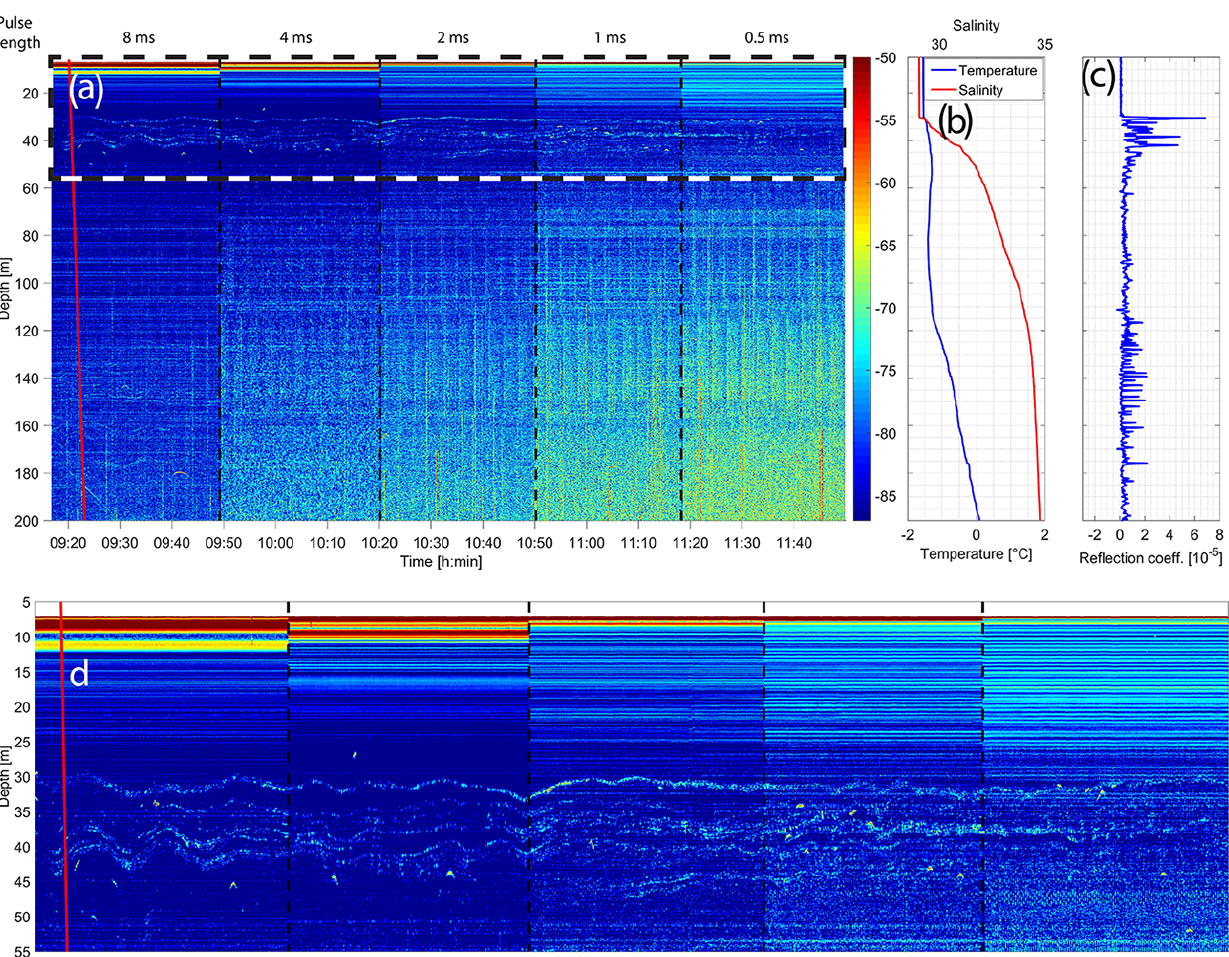
Figure 4. Comparison of EK80 data with different pulse lengths. Data were acquired on 26 August 2016 at 140.6 ◦ W, 86.8 ◦ N. (a) EK80 echogram. (b) CTD profiles showing temperature (blue) and salinity (red). (c) Reflection coefficients derived from CTD data. (d) Enlargement of dashed box in (a) . In (a) and (d) , the vertical red line is the CTD position and the vertical dashed black lines indicate changes in pulse length (decreasing from 8 to